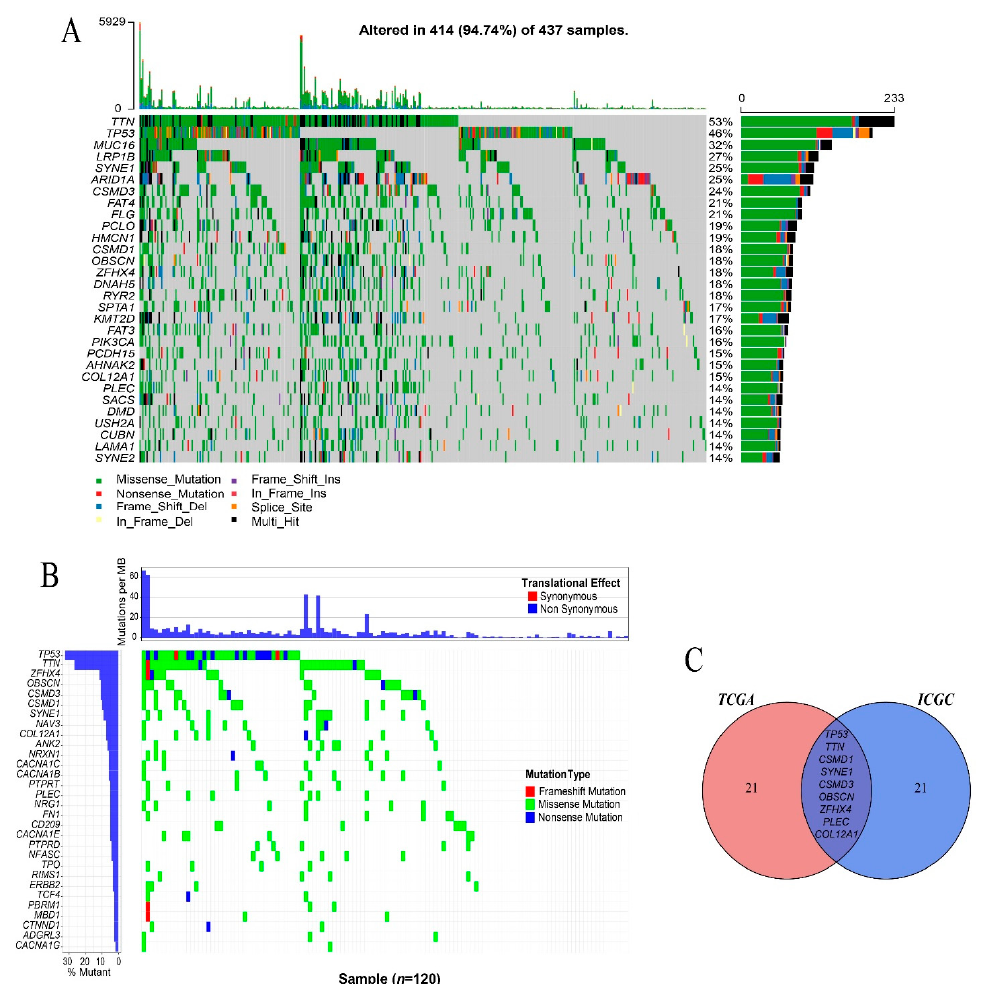
Figure 1. Gene mutation landscape in gastric cancer. ( A ) The waterfall plot of top 30 genes with frequent mutations in the TCGA gastric cancer cohort shows the names of the top 30 genes on the left, the frequency of gene mutation on the right, the total number of somatic mutations in each sample at the top, and the type of mutation at the bottom. ( B ) The waterfall plot of the top 30 genes with frequent mutations in the ICGC gastric cancer cohort shows the name and mutation frequency of the top 30 genes on the left, the average number of mutations per Mb in each sample at the top, and the type of mutation on the right. ( C ) The Venn diagram shows nine genes mutated in both of the TCGA and ICGC cohorts.